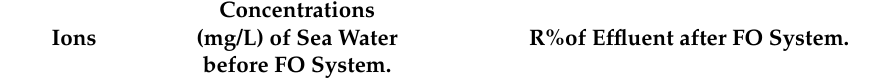
Table 8. Characteristics of real saline water sample prior and post FO desalination of Neat CTA, CTA/0.3%GO, and TFC modified membranes and NaCl as the DS.